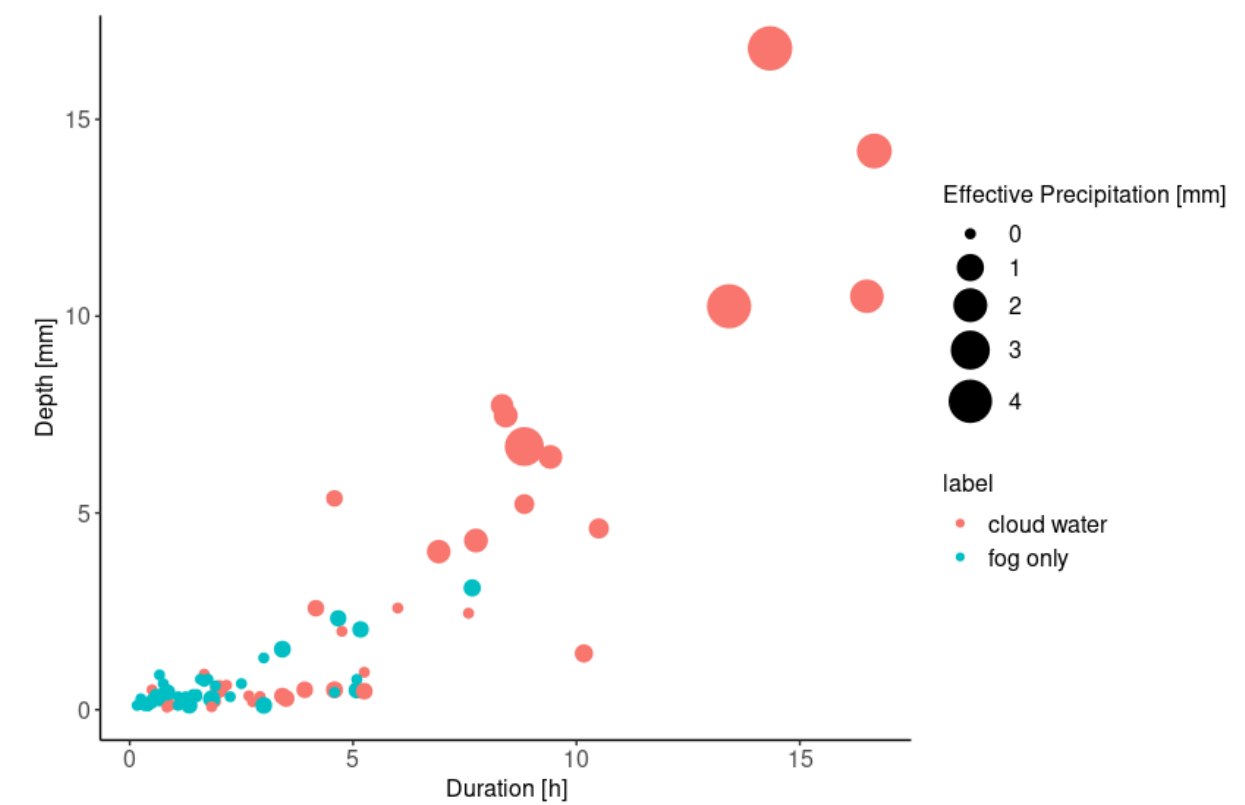
Figure 8. Relationship among duration, total event depth and effective precipitation for the 82 events.